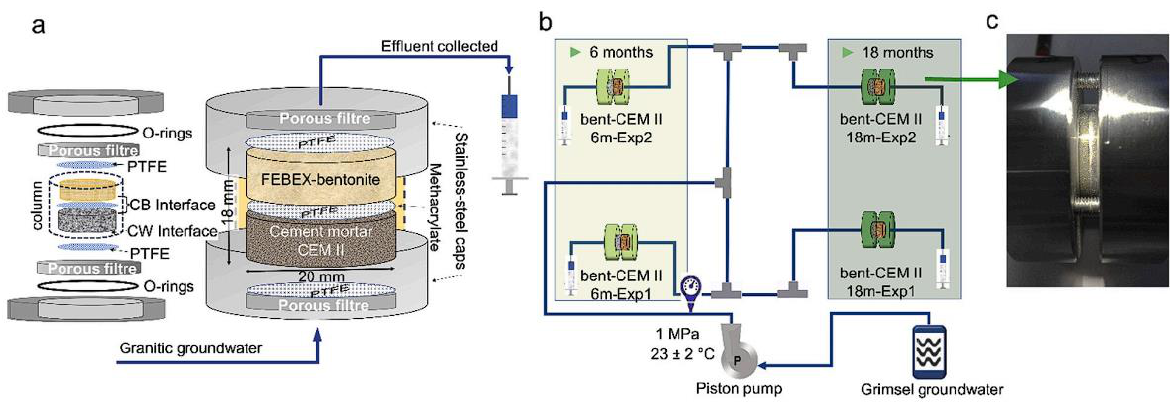
Figure 23. Arrangement of transport cells: ( a ) cell structure; ( b ) experimental setup; ( c ) photo of concrete/bentonite interface in of one cell [13].